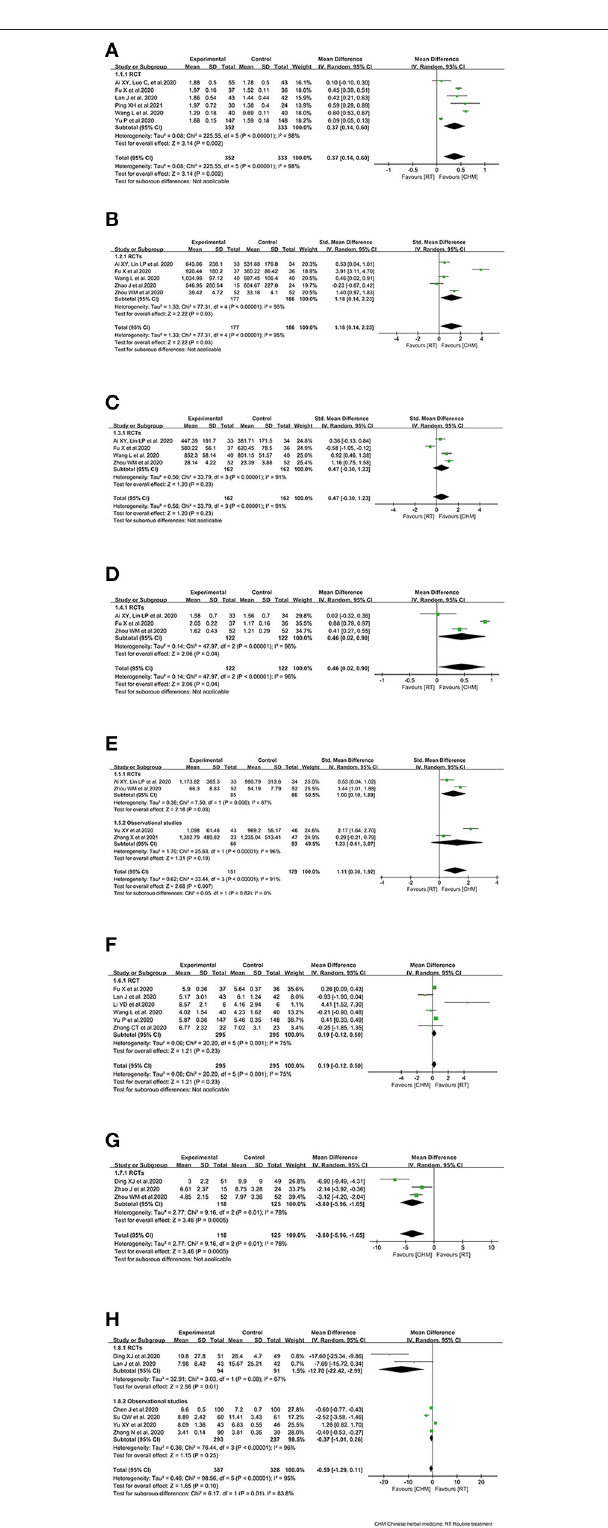
FIGURE 2 | Effect of Chinese herbal medicine as an adjuvant on immunity profiles during COVID-19. (A) Lymphocyte count. (B) CD4 + . (C) CD8 + . (D) CD4 + /CD8 + . (E) CD3 + . (F) Leukocyte count. (G) TNF- α . (H) IL-6.